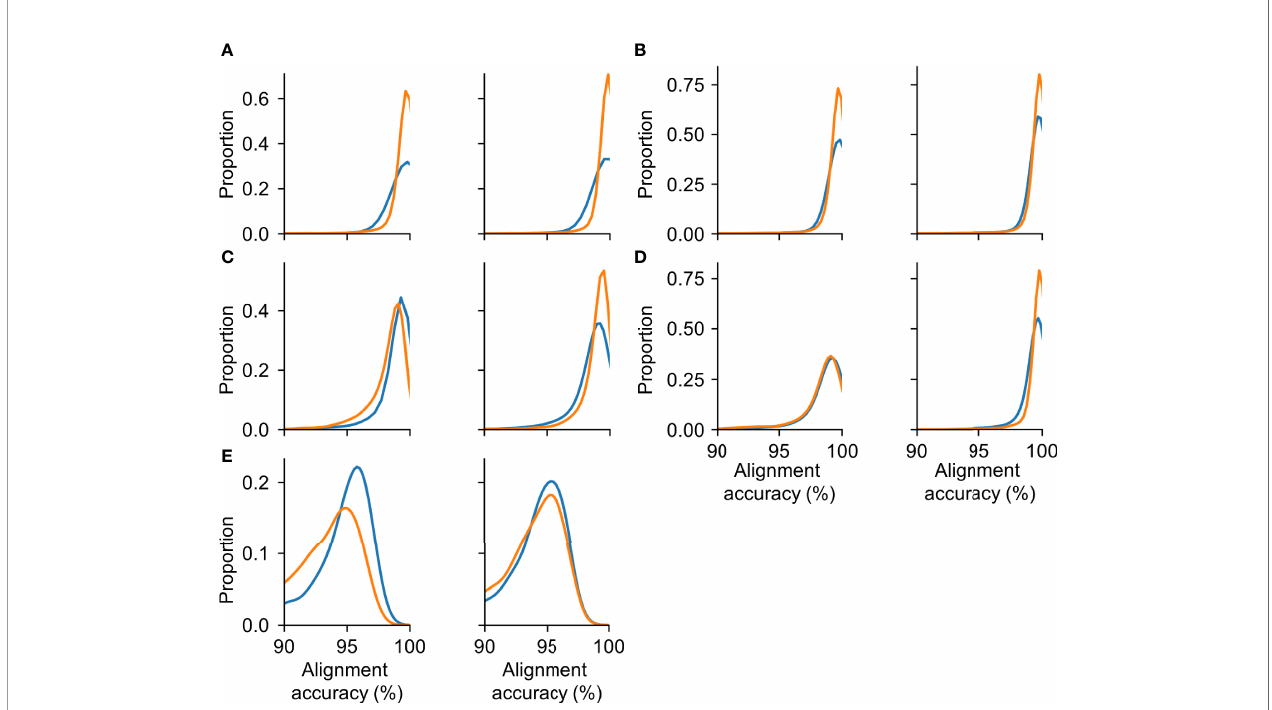
FIGURE 8 | HIV-Quasipore achieved a similar mean read accuracy for evaluation and training data. The distribution of observed read alignment accuracies using different training and evaluation datasets for (A) R9.4.1 SUP, (B) R10.3 SUP, (C) R9.4.1 HAC, (D) R10.3 HAC, and (E) R9.4.1 fast. The left panels correspond to models that were trained using the fi rst half of the trace data generated during sequencing and evaluated using trace data from the second half of the sequencing. The right panels correspond to the opposite training-evaluation scheme. Blue and orange lines represent the read accuracy distribution of data observed during the fi rst and fi nal halves of sequencing, respectively. While the distribution is constructed using all mapped reads, only reads with an alignment accuracy of ≥ 90% are